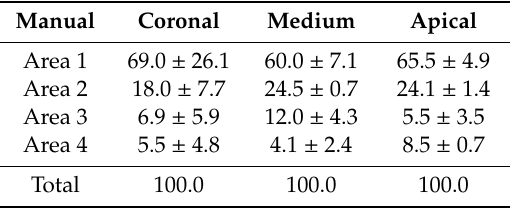
Table 5. Root canal areas identified by ESEM-EDX and expressed as percentages (mean ± SD) of retreated teeth using manual K-file instruments.